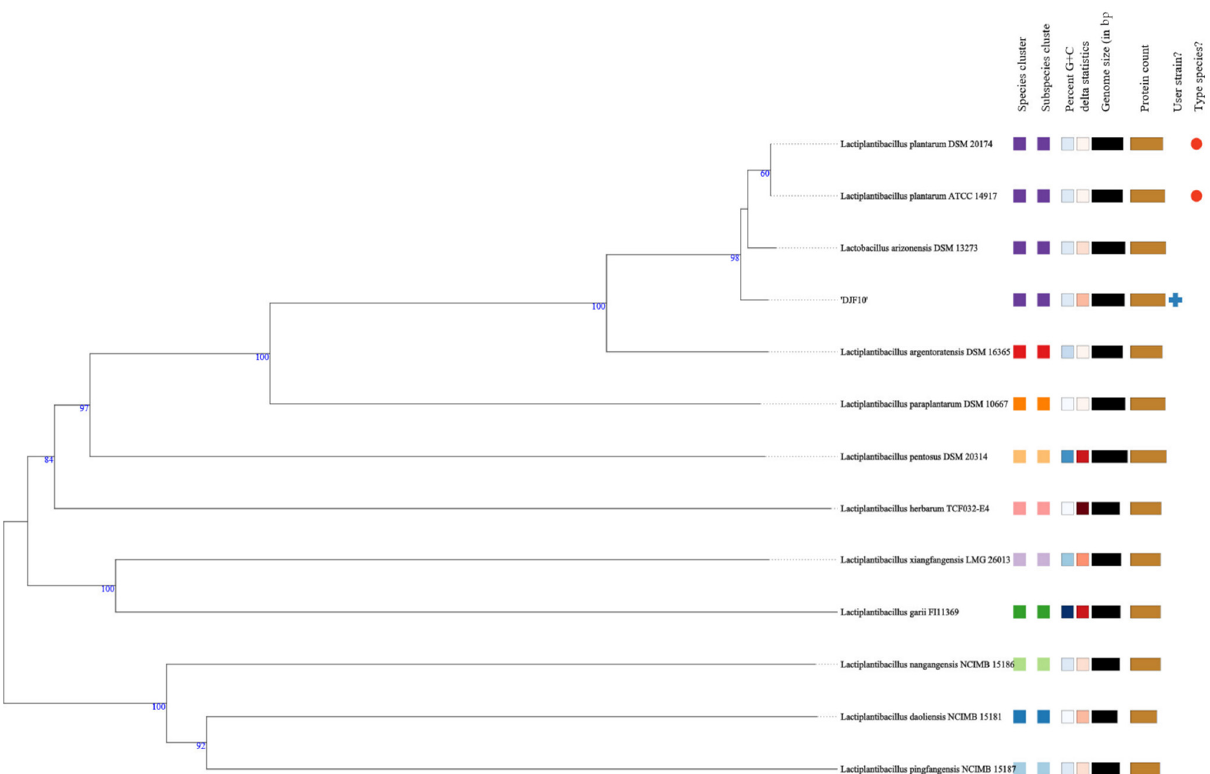
Figure 2. Phylogenetic comparison of Lactiplantibacillus plantarum DJF10 with representative complete genomes of other Lactiplantibacillus strains carried out in TYGS webserver. The tree was inferred with FASTME 2.1.6.1. from GBDP distances calculated from 16S rDNA gene sequences. The bootstrap support value before each node represents the confidence degree of each branch. Table 1. General genome features of Lactiplantibacillus plantarum